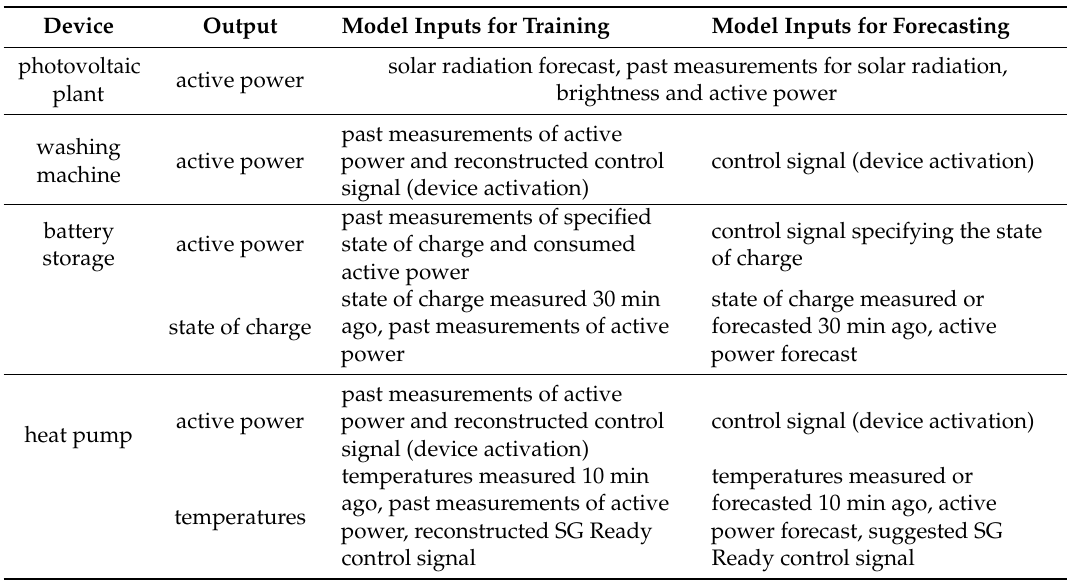
Table 3. Model inputs for all devices for the training (during Phase 1) and the forecasting (during Phase